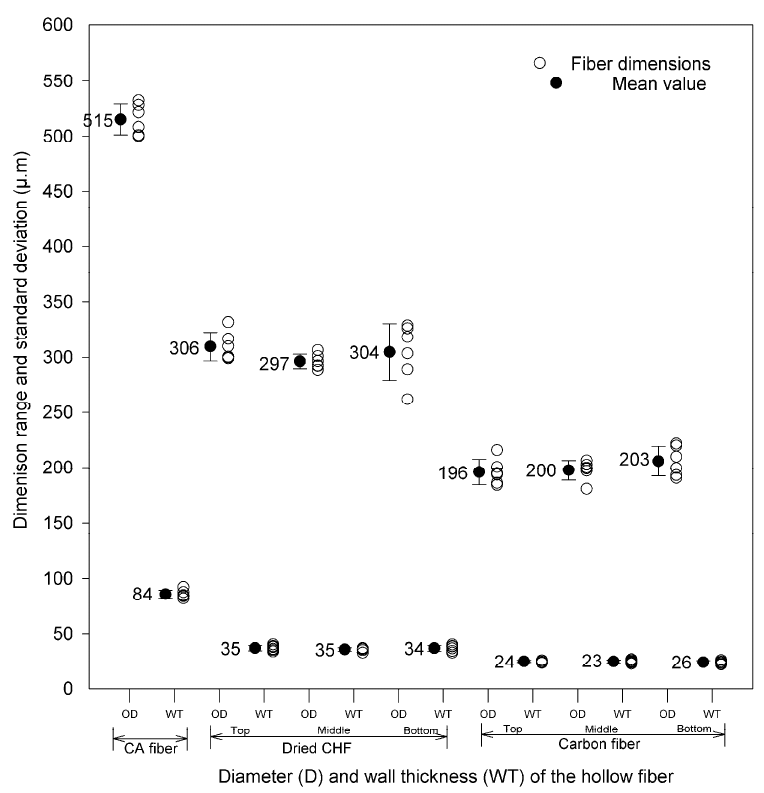
Figure A2. Outer diameter (OD) and wall thickness (WT) of CAHF, CHF, and CM at different positions of the fiber.